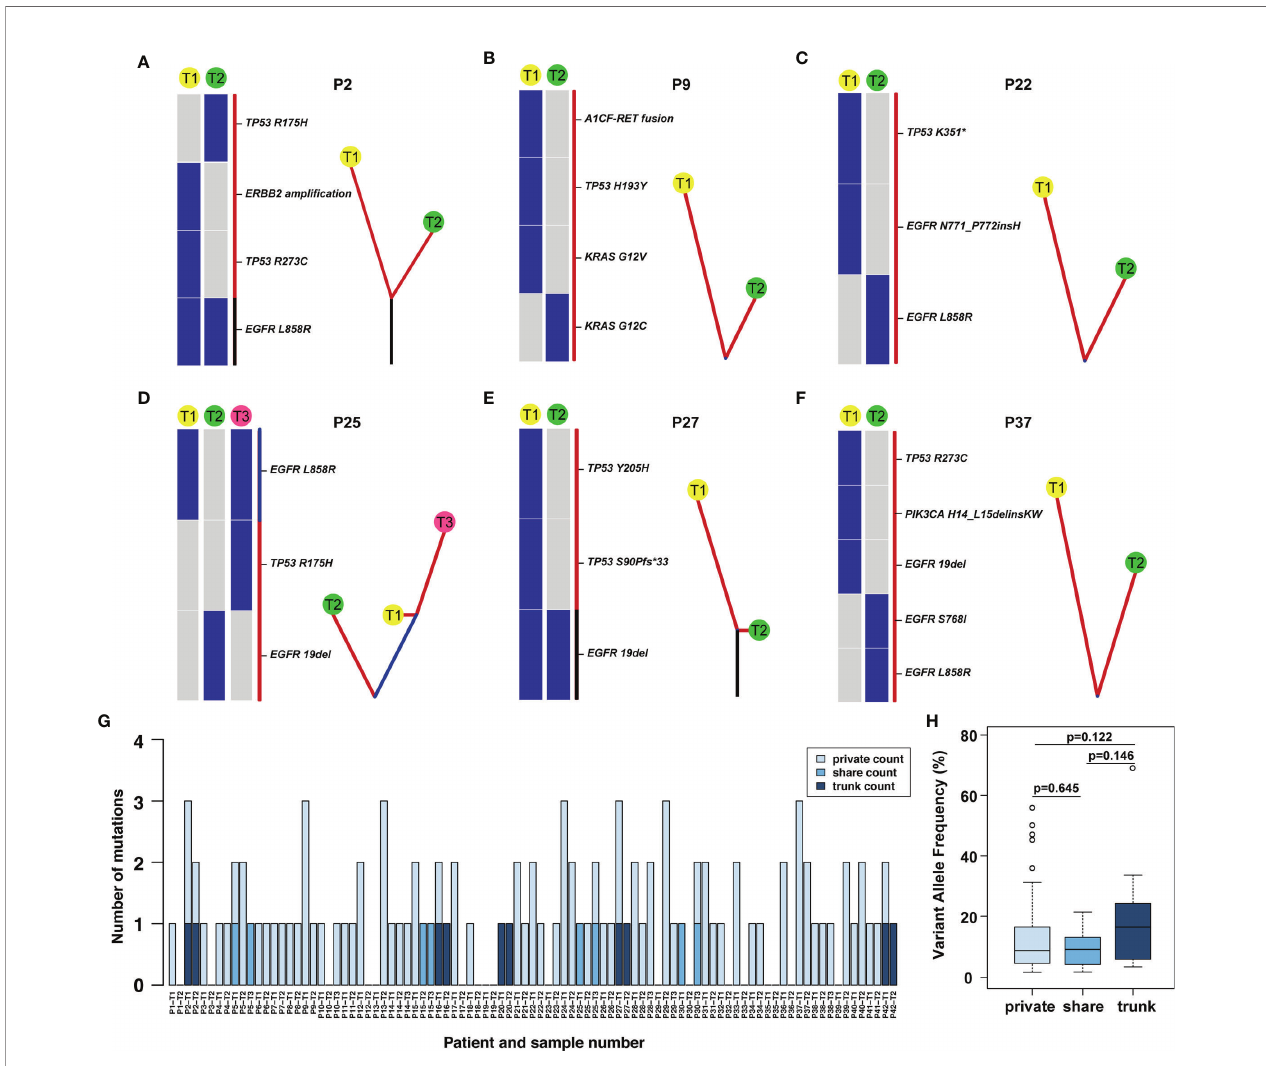
FIGURE 3 | Phylogenetic tree and the distribution of trunk, shared, and private mutations. (A – F) The heat map on the left of each panel describes the regional distribution of all somatic mutations. The maximum parsimony algorithm was used to construct a phylogenetic tree for each patient on the right side of each panel. The mutation categories shown in the heat map are represented by the colour of each line, and the length of the trunk and branches are proportional to the number of mutations in each lesion. (G) The distribution of trunk, shared and branch mutations of 93 synchronous multiple primary lung adenocarcinoma lesions de fi ned by next-generation sequencing. (H) The variant allele frequency (VAF) of the trunk, share and private